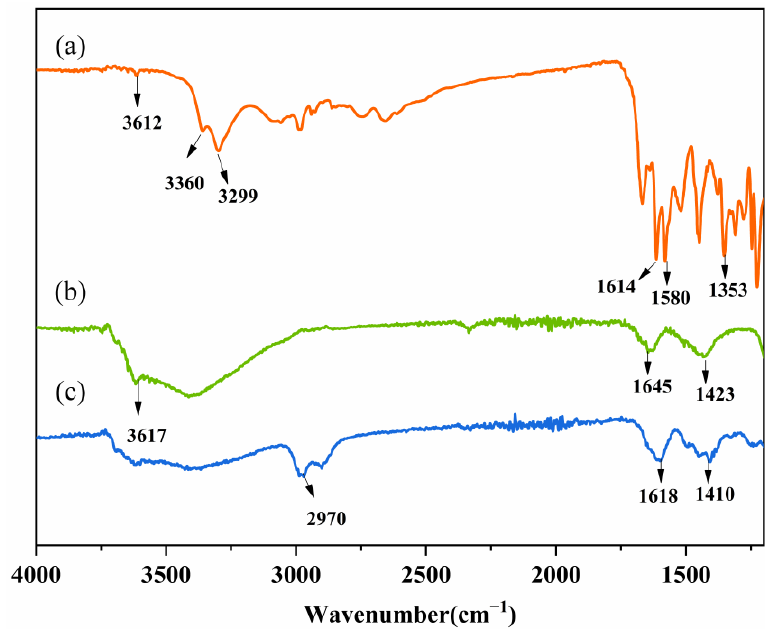
Figure 4. FTIR spectra of: ( a ) TC; ( b ) sediment M4; and ( c ) TC-adsorbed sediment M4.